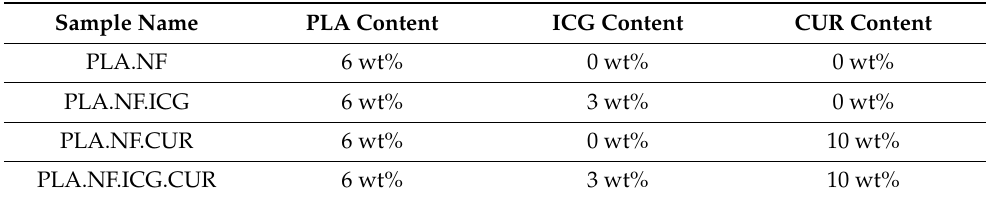
Table 1. Poly( D , L -lactide) (PLA) content (relative to the mass of total spinning solution), indocyanine green (ICG) content (relative to PLA mass), curcumin (CUR) content (relative to PLA mass) of